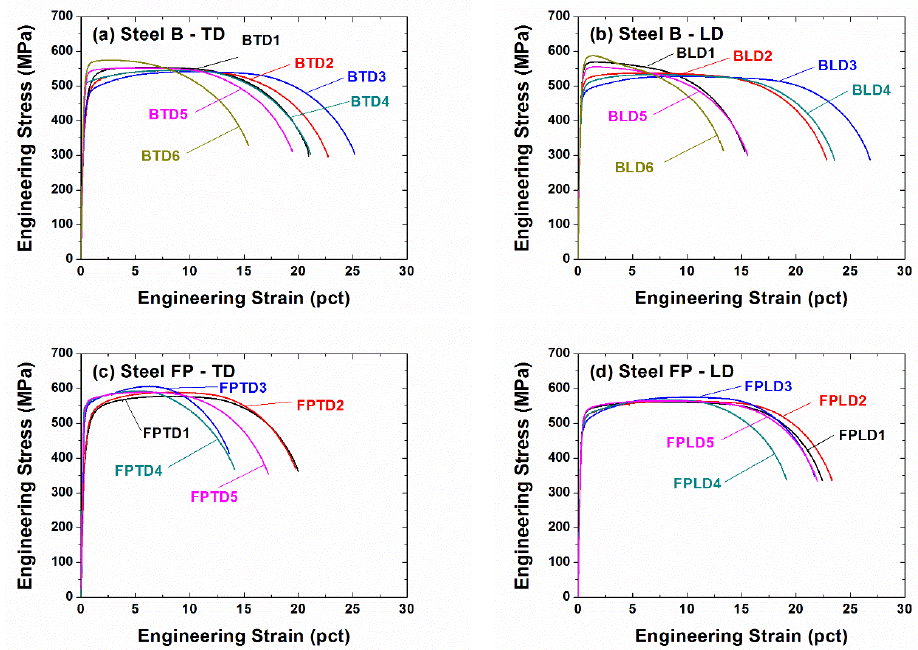
Figure 5. Representative engineering stress-strain curves for ( a ) steel B-TD, ( b ) steel B-LD, ( c ) steel FP-TD and ( d ) steel FP-LD after flattening. The numbers after the sample designation indicate through-thickness position.